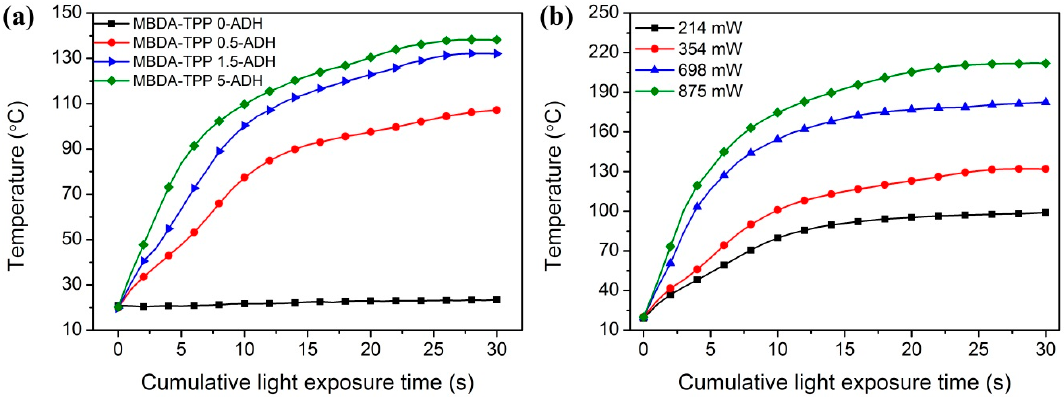
Figure 5. Light (655 nm)-induced heating rises of various films (thickness: 0.3 mm). ( a ) Temperature of films loaded with different TPP vs . exposure time under 354 mW/cm 2 lamp within 30 s; ( b ) effect of light intensity (214, 354, 698, and 875 mW) on laser-induced heating of a MBDA–TPP 1.5–ADH